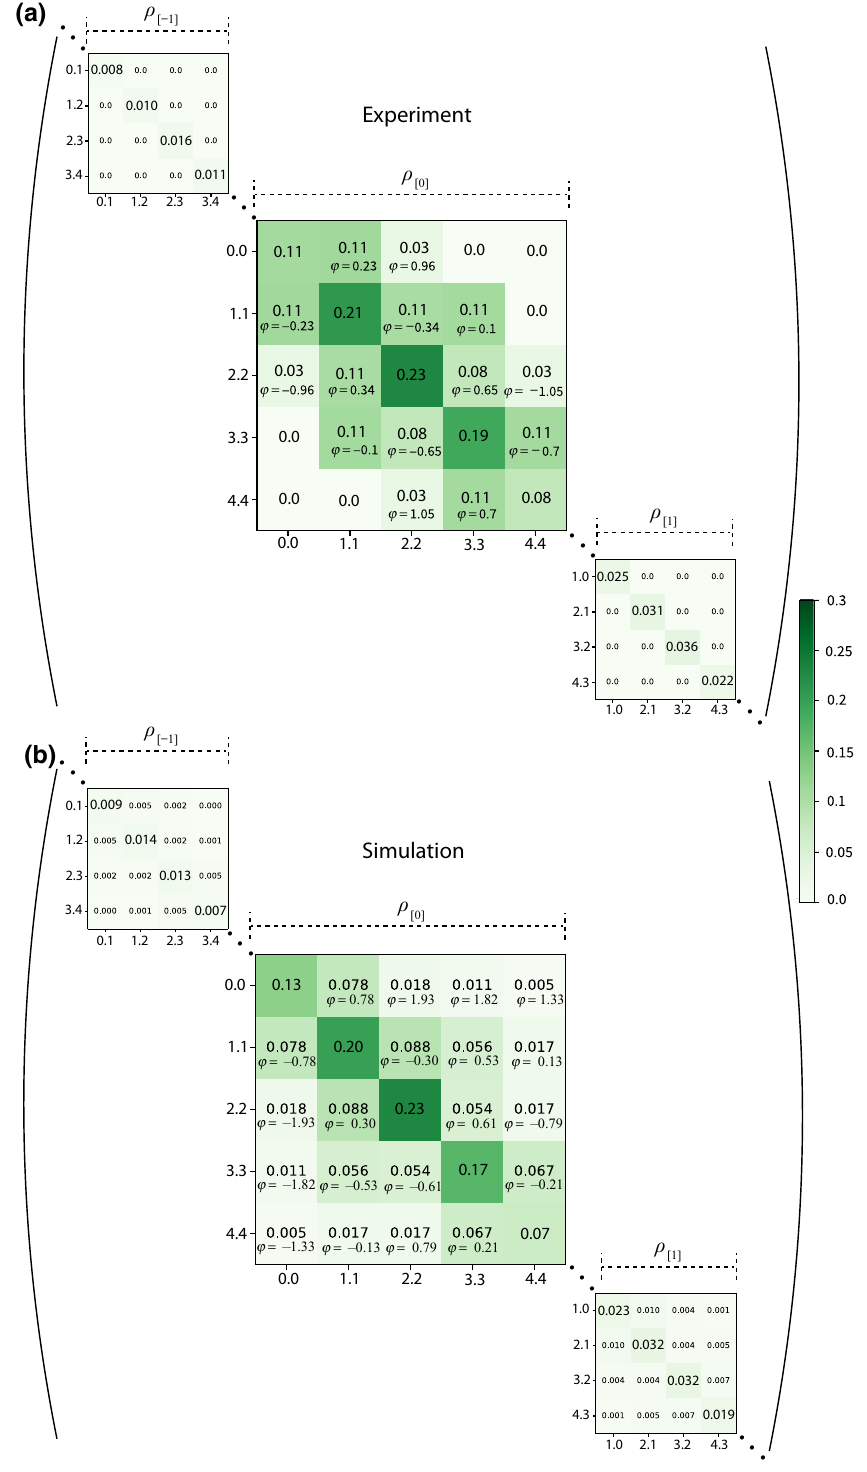
FIG. 8. The density matrix from experiment versus the simulation. (a) The experimental density matrix ρ M measured using the quantum subspace-tomography method discussed in the main text for d = 2 after pumping for t = 15 µ s and with a wait time of t w = 4.5 µ s. (b) The simulated density matrix with the system parameters in Table II and rates extracted from the time-domain data fits as in Fig. 2, with the same t and t w